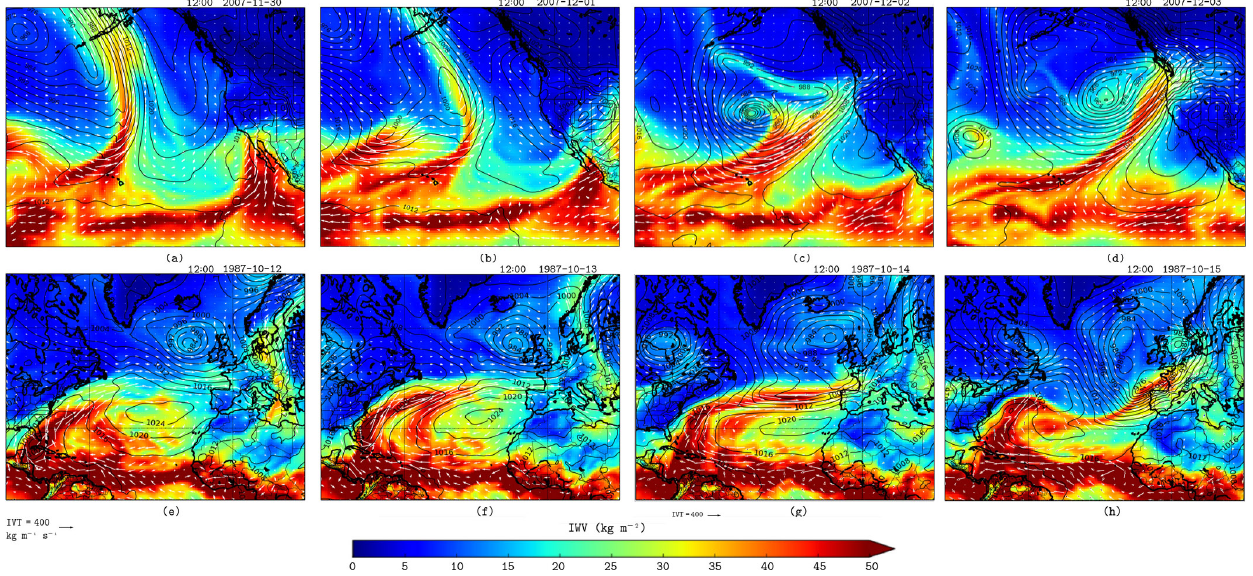
Figure 1. Integrated vapor transport (IVT, vectors, kgm − 1 s − 1 ), sea level pressure (isobars, hPa) and integrated water vapor (IWV, back- ground, kgm − 2 ) fields for both the Great Coastal Gale of 2007 (a–d) and the Great Storm of 1987 (e–h) events throughout a 4-day time frame. Source: